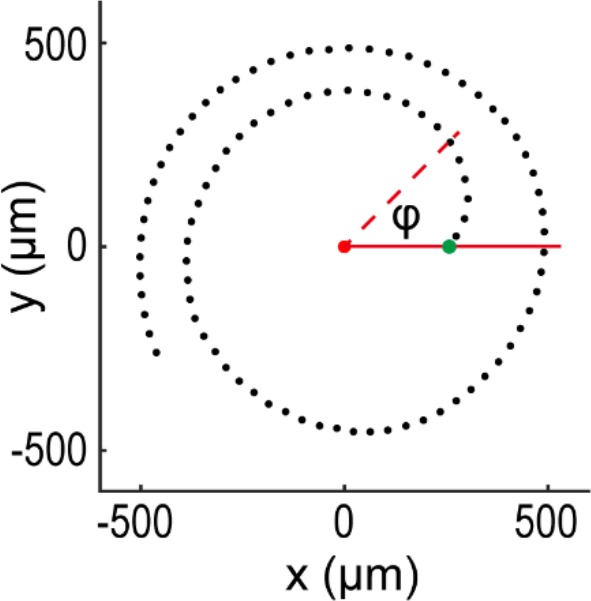
An example of inner hair cell locations (black dots) viewed from the axial direction.The angle (φ) was measured from the line (red line) connecting the center of the spiral and the inner hair cell located at the end of the apex (green dot).